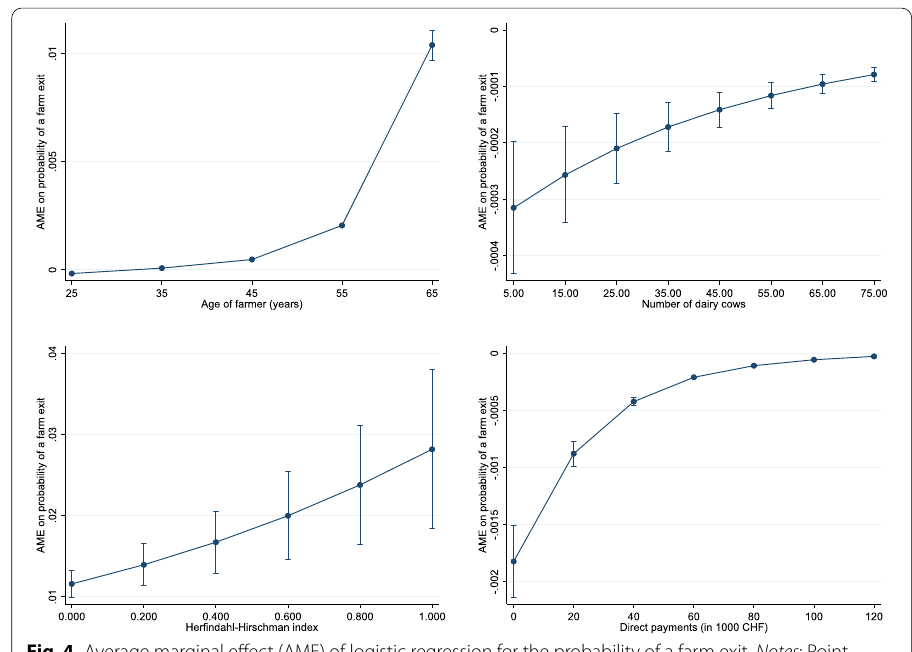
Fig. 4 Average marginal effect (AME) of logistic regression for the probability of a farm exit. Notes : Point estimates (solid line) with 95% confidence interval (dashed lines). Direct payments are measured on an annual basis in 1000 Swiss francs